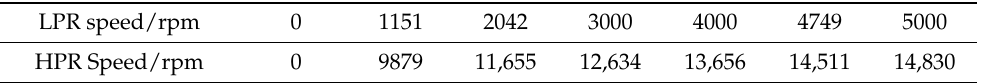
Table 2. High- and low-pressure rotors work together with the